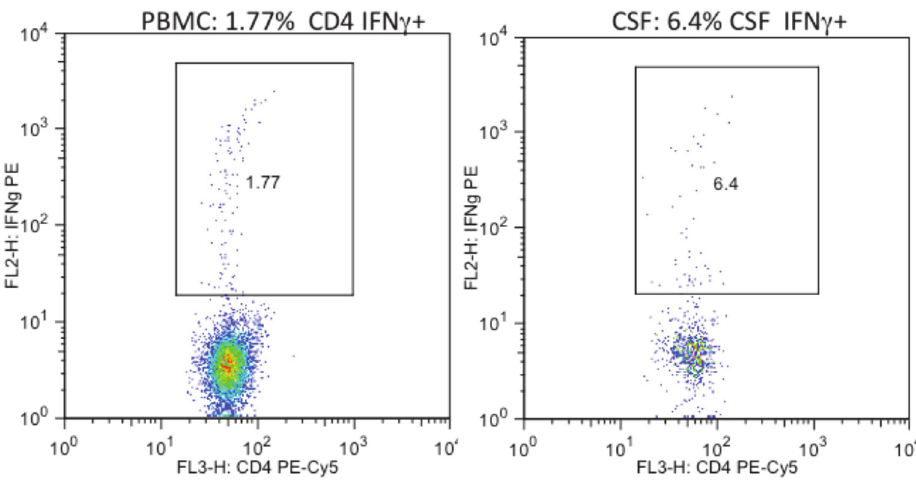
Fig 1. The frequency of HIV specific CD4 T-cells expressing IFN γ in the CSF was higher than in peripheral blood. PBMC (1a) and CSF (1b) cells from the same HIV+ donor were cultured overnight with HIV p24 antigen and stained for intracellular IFN γ